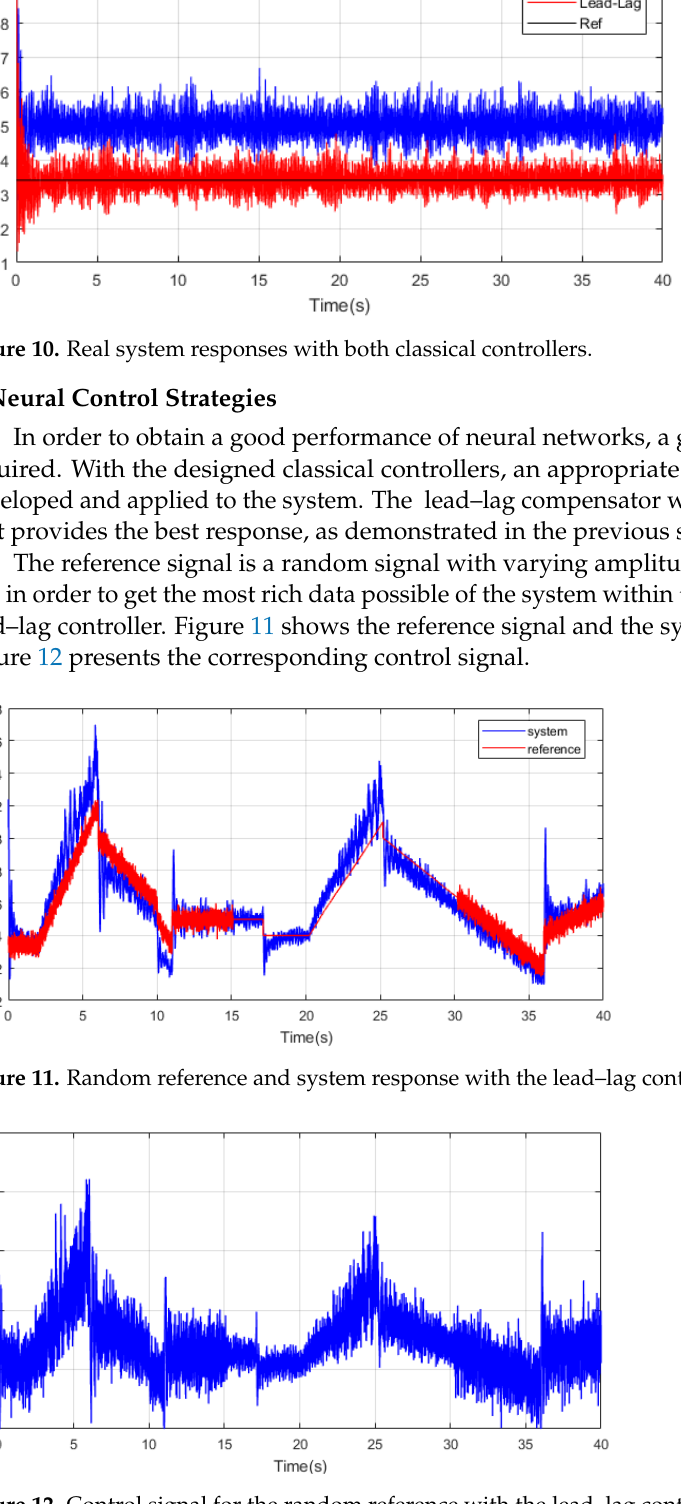
Figure 12. Control signal for the random reference with the lead–lag